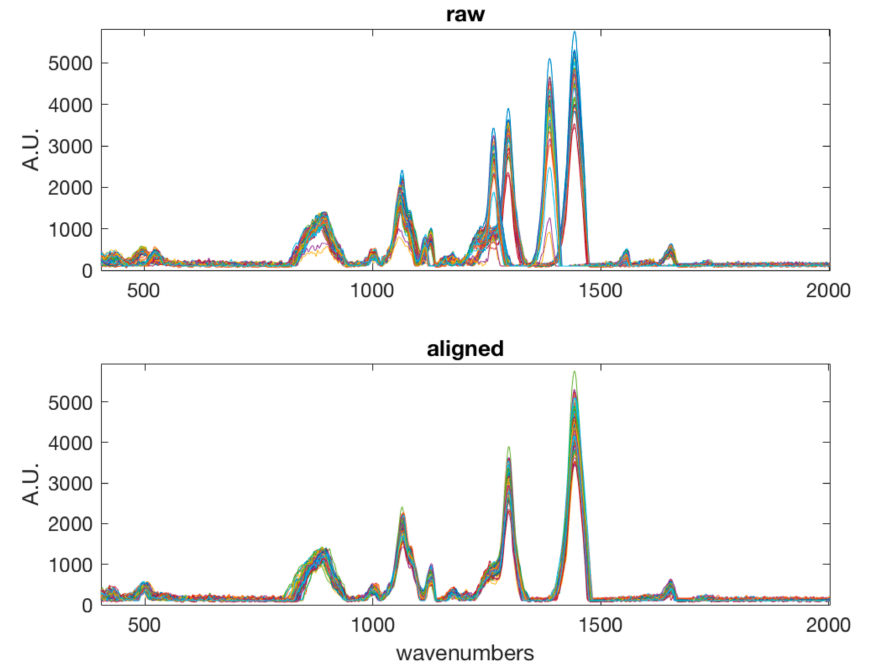
Figure 1. Raw ( top ) and aligned spectra ( bottom